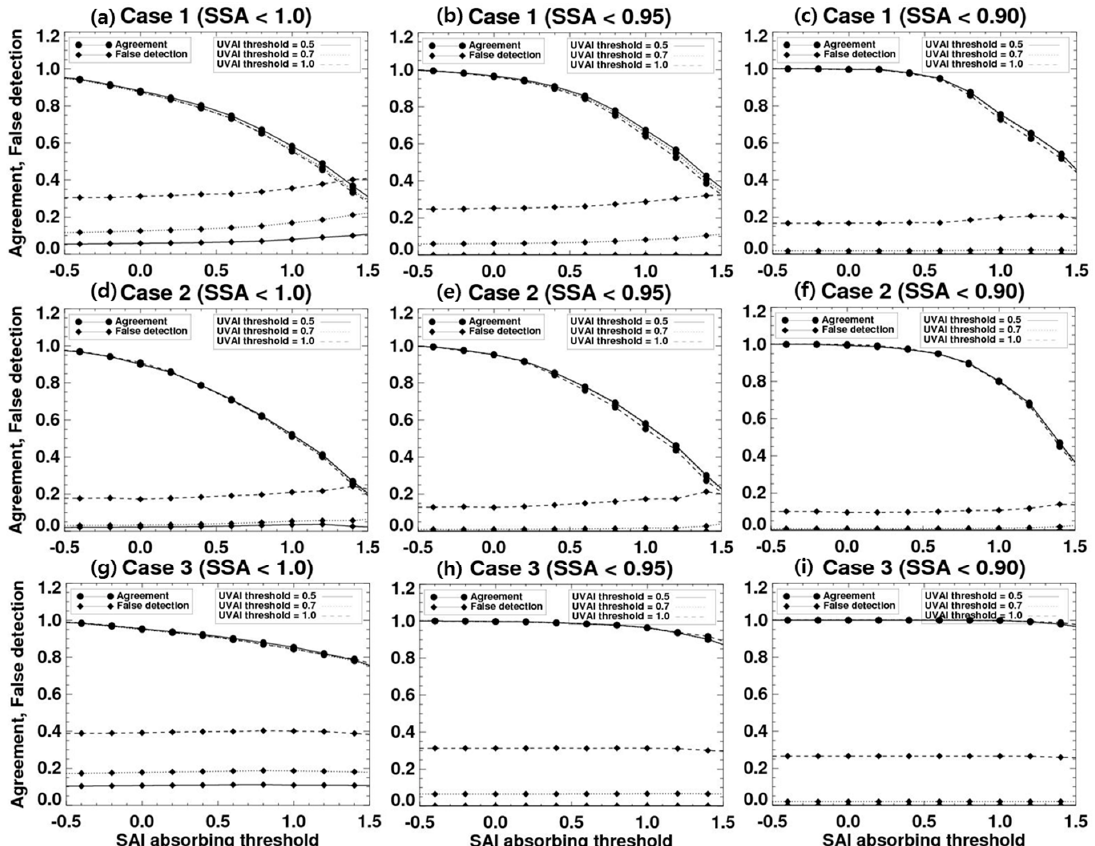
Figure 7. ( a – i ) Results of an agreement and false detection test of OMI UVAI and OMI SAI for 8 April (Case 1) and 23 April (Case 2, Case 3) 2006, respectively. The x-axis indicates the SAI absorbing threshold ranging from − 0.5 to 1.5. The different line styles indicate different UVAI threshold values. The SAI value of 0.5 corresponds to a UVAI value of 0.7. The false detection rate is constant, indicating that the current SAI algorithm correctly defines the absorbing aerosol pixels.